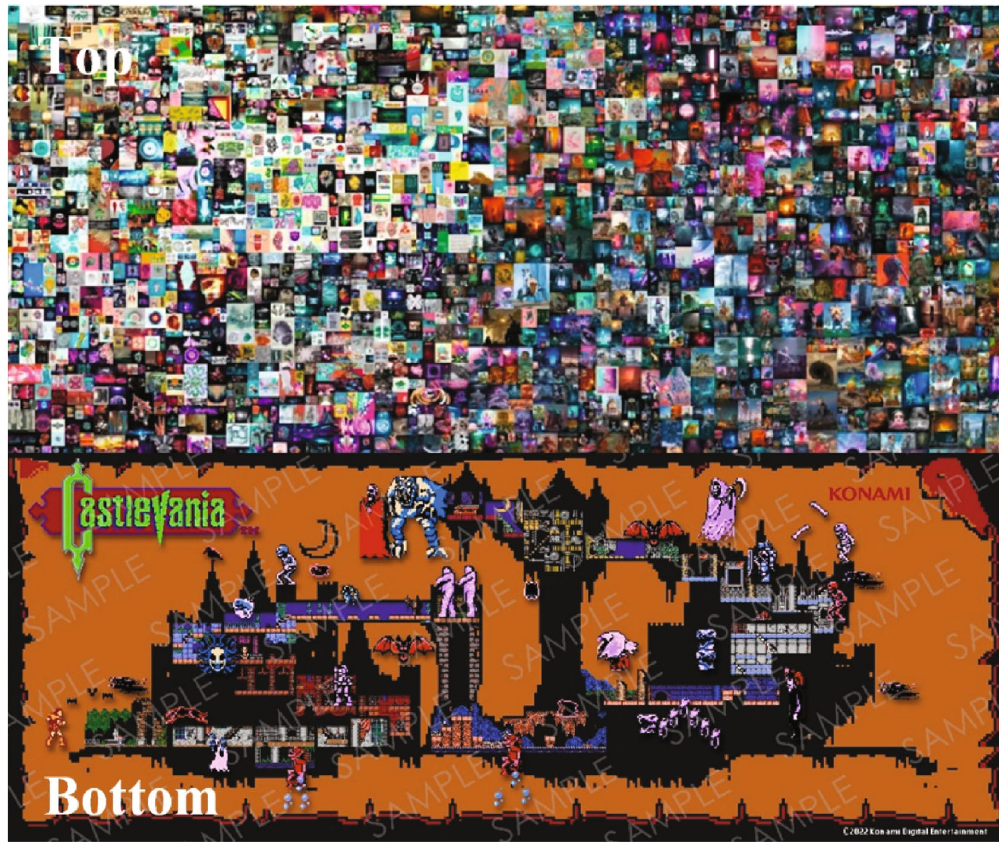
Figure 1: Iconic NFTs: The First 5000 Days by Beeple (top) and Konami ’ s Castlevania-related works